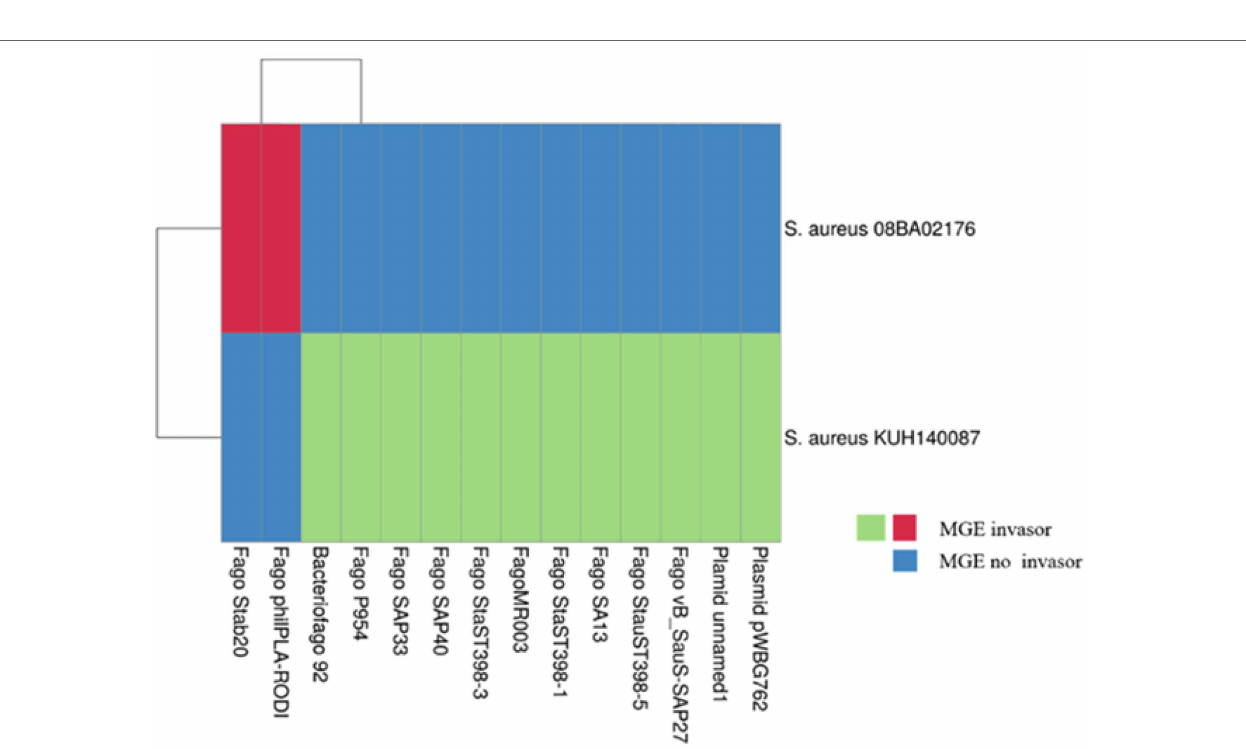
FIGURE 4 | Secondary structures of repeated sequences. Each secondary structure is the result of the interactions of the nucleotides; these structures and the minimum free energy were obtained in the RNAfold server. It shows the scale of occurrence for each nucleotide interaction.